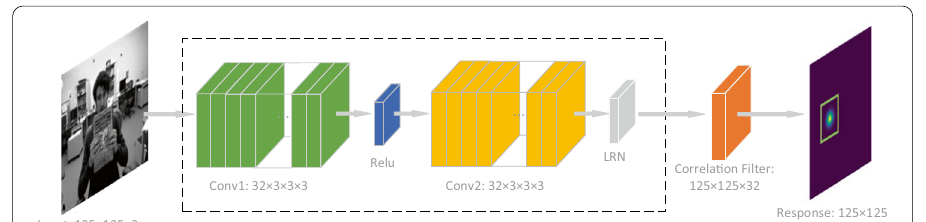
Fig. 7 The overall network